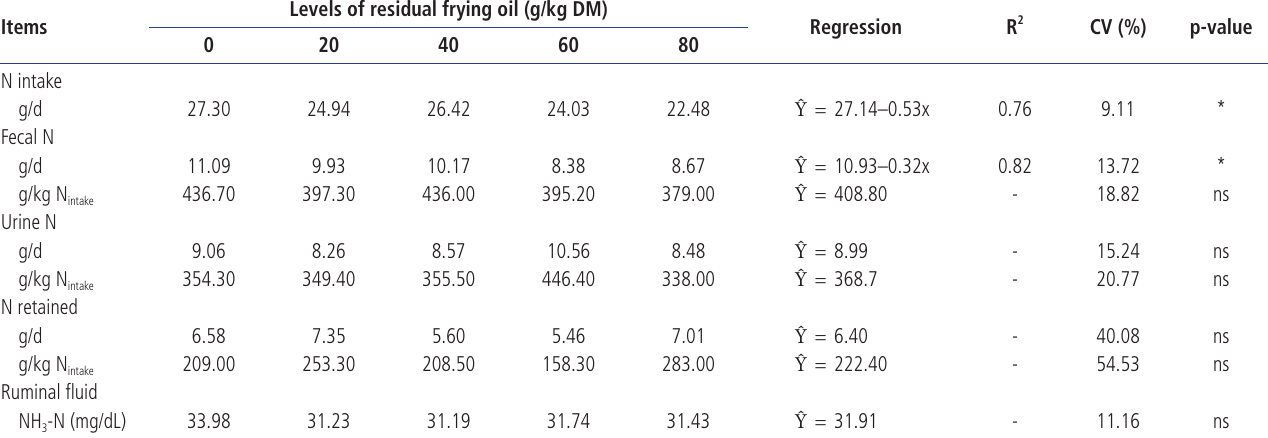
Table 4. Intake, excretion, nitrogen balance and ruminal ammonia nitrogen of lambs fed diets with different levels of residual frying oil